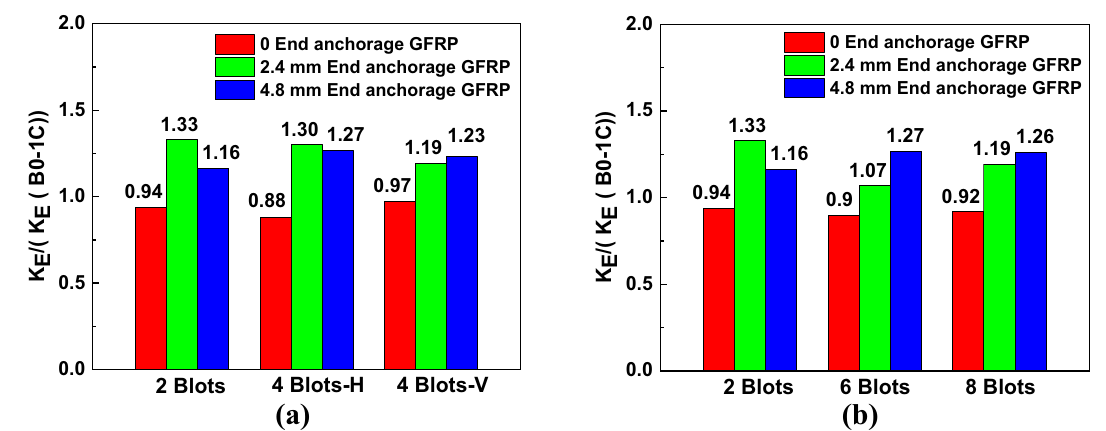
Fig. 9 Normalized elastic stiffness versus bolt quatity (diameter 10 mm) and end-anchorage